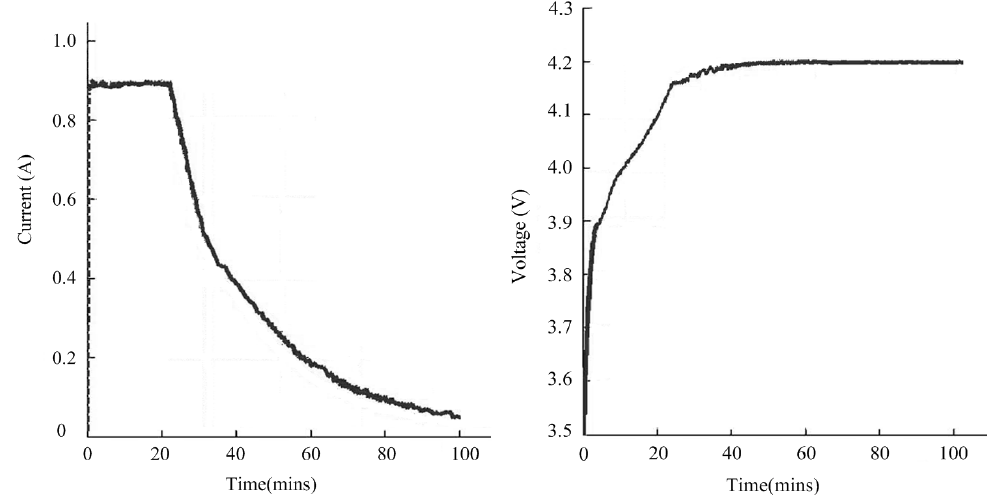
Figure 12. Measured profiles of charging current (A) and charging voltage (V) of a single battery cell implementing the constant current/constant voltage (CC/CV) method (min).